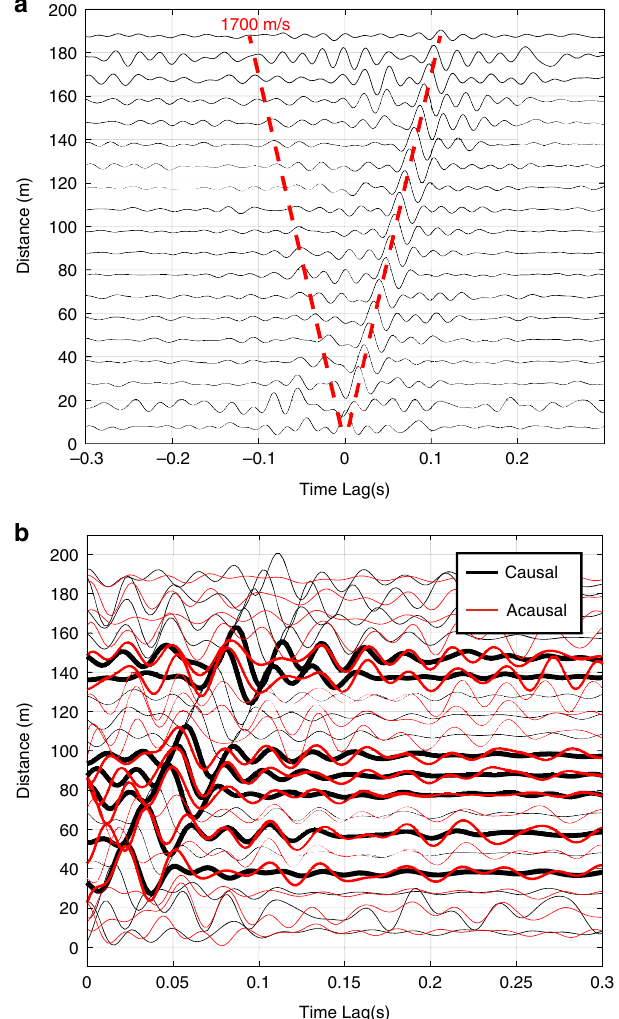
Fig. 6 Noise correlation stacks. Recorded on 24 March 2019, the stack includes 1081 cross-correlations from 47 channels of the eastern triangle side binned within fi xed distance intervals of 10 m. a Cross-correlations showing Rayleigh wave propagation at 1700 m/s. b Acausal part folded onto the causal part of the cross-correlation. Although the acausal SNR of the virtual surface wave is weaker than the causal one, comparison of the two nevertheless shows that some energy propagates in both directions along the cable. Bold traces show the highest symmetry between the causal and acausal